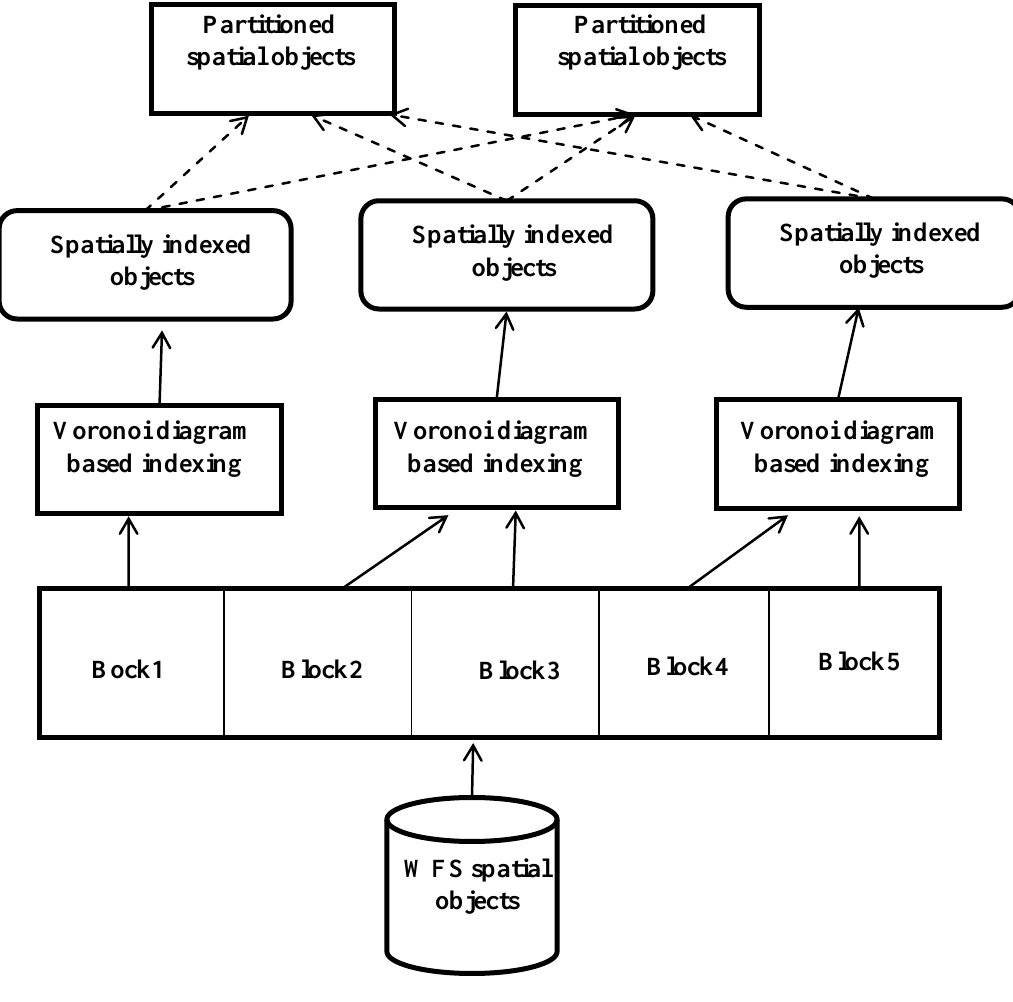
Figure 4. The procedure of indexing spatial objects using a Voronoi